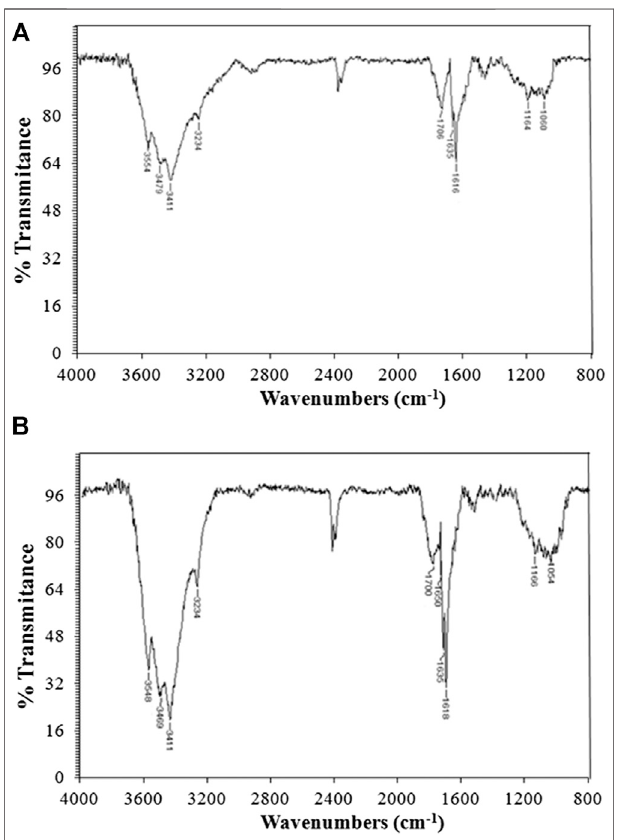
FIGURE2 | FT-IR spectra of: (A) biocarbon from raw kraft pulp (BK) and (B) biocarbon from acid-treated kraft pulp (TBK).